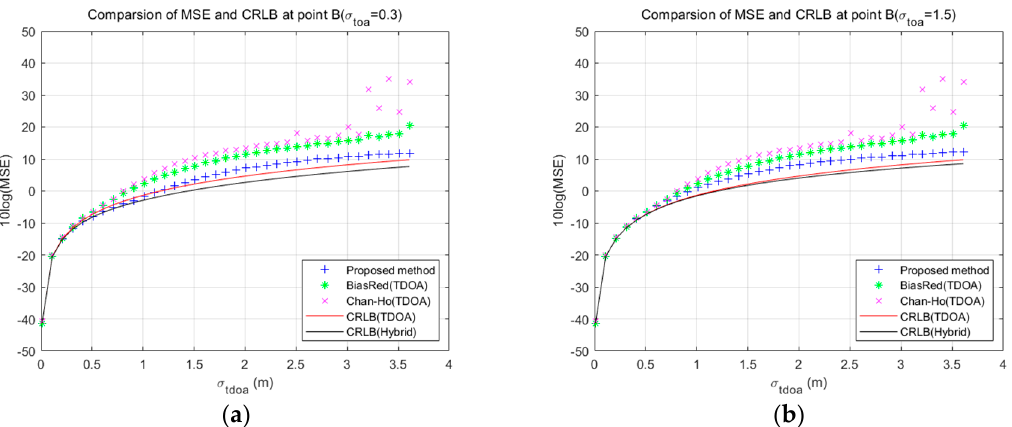
Figure 11. Accuracy of different positioning method at point B; ( a ) positioning error MSE when the standard deviation of TOA ranging error is 0.3 m; ( b ) positioning error MSE when the standard deviation of TOA ranging error is 1.5 m.